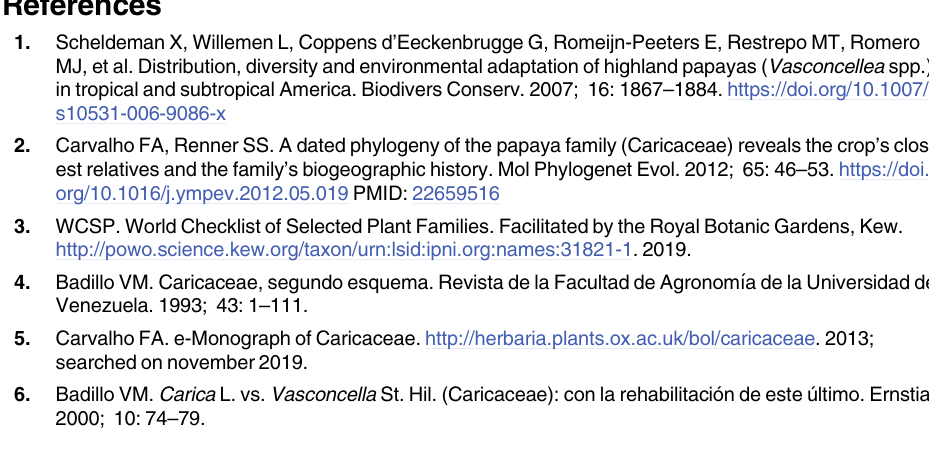
S3 Table. Highest posterior probabilities of the six-gene Bayesian species delimitation analysis (BPP) by jointing species delimitation and species tree inference. S4 Table. Morphological comparisons among species of the genus Vasconcellea